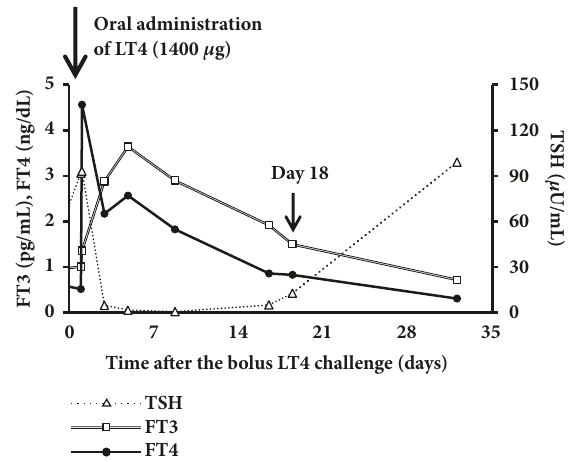
Figure 4: Serum thyroid hormone and TSH levels after the oral administration of a single bolus of LT4 (1400 𝜇 g) . Eighteen days after the administration, serum FT4 and FT3 levels were 0.83 ng/dL and 1.5 pg/mL, respectively. Her serum TSH levels were 12.78 𝜇 IU/mL.